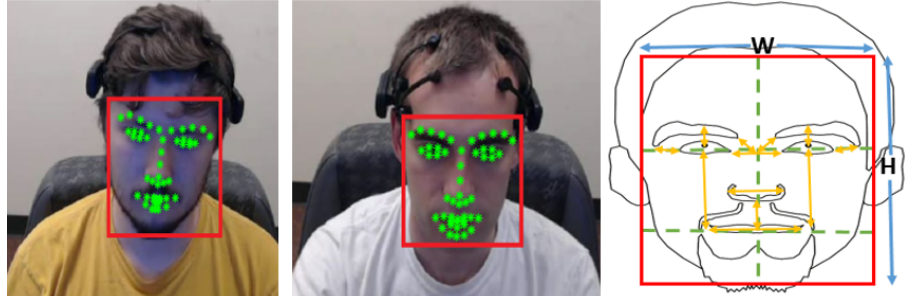
Figure 3. Detected face (marked in red) and face localized points (marked in green) for two participants (left and center) in the study, and some of the features (marked in yellow) computed using the coordinates of the face localized points. These features were then normalized using the size of the face in the camera i.e., number of pixels in height (H) and width